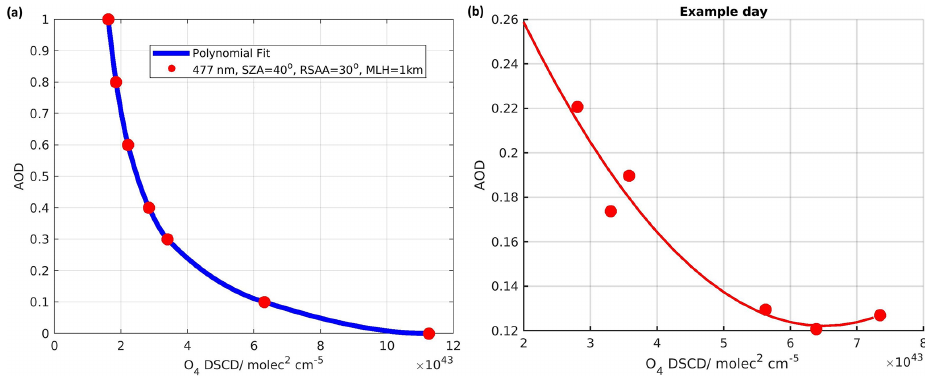
Figure 4. (a) Dots: simulated AOD for NO 2 box profile of 1km at 477nm for an SZA of 40 ◦ and RAA of 30 ◦ as a function of the simulated O 4 dSCDs for the different AOD values (1, 0.8, 0.6, 0.4, 0.3, 0.1, and 0; see Table 2). Blue line: simulated AOD by applying an exponential fit through the data points. (b) Dots: estimated AOD in the six wavelengths used in the retrieval for 1 example day (11 September 2018). Red line: fitted line through the data points.